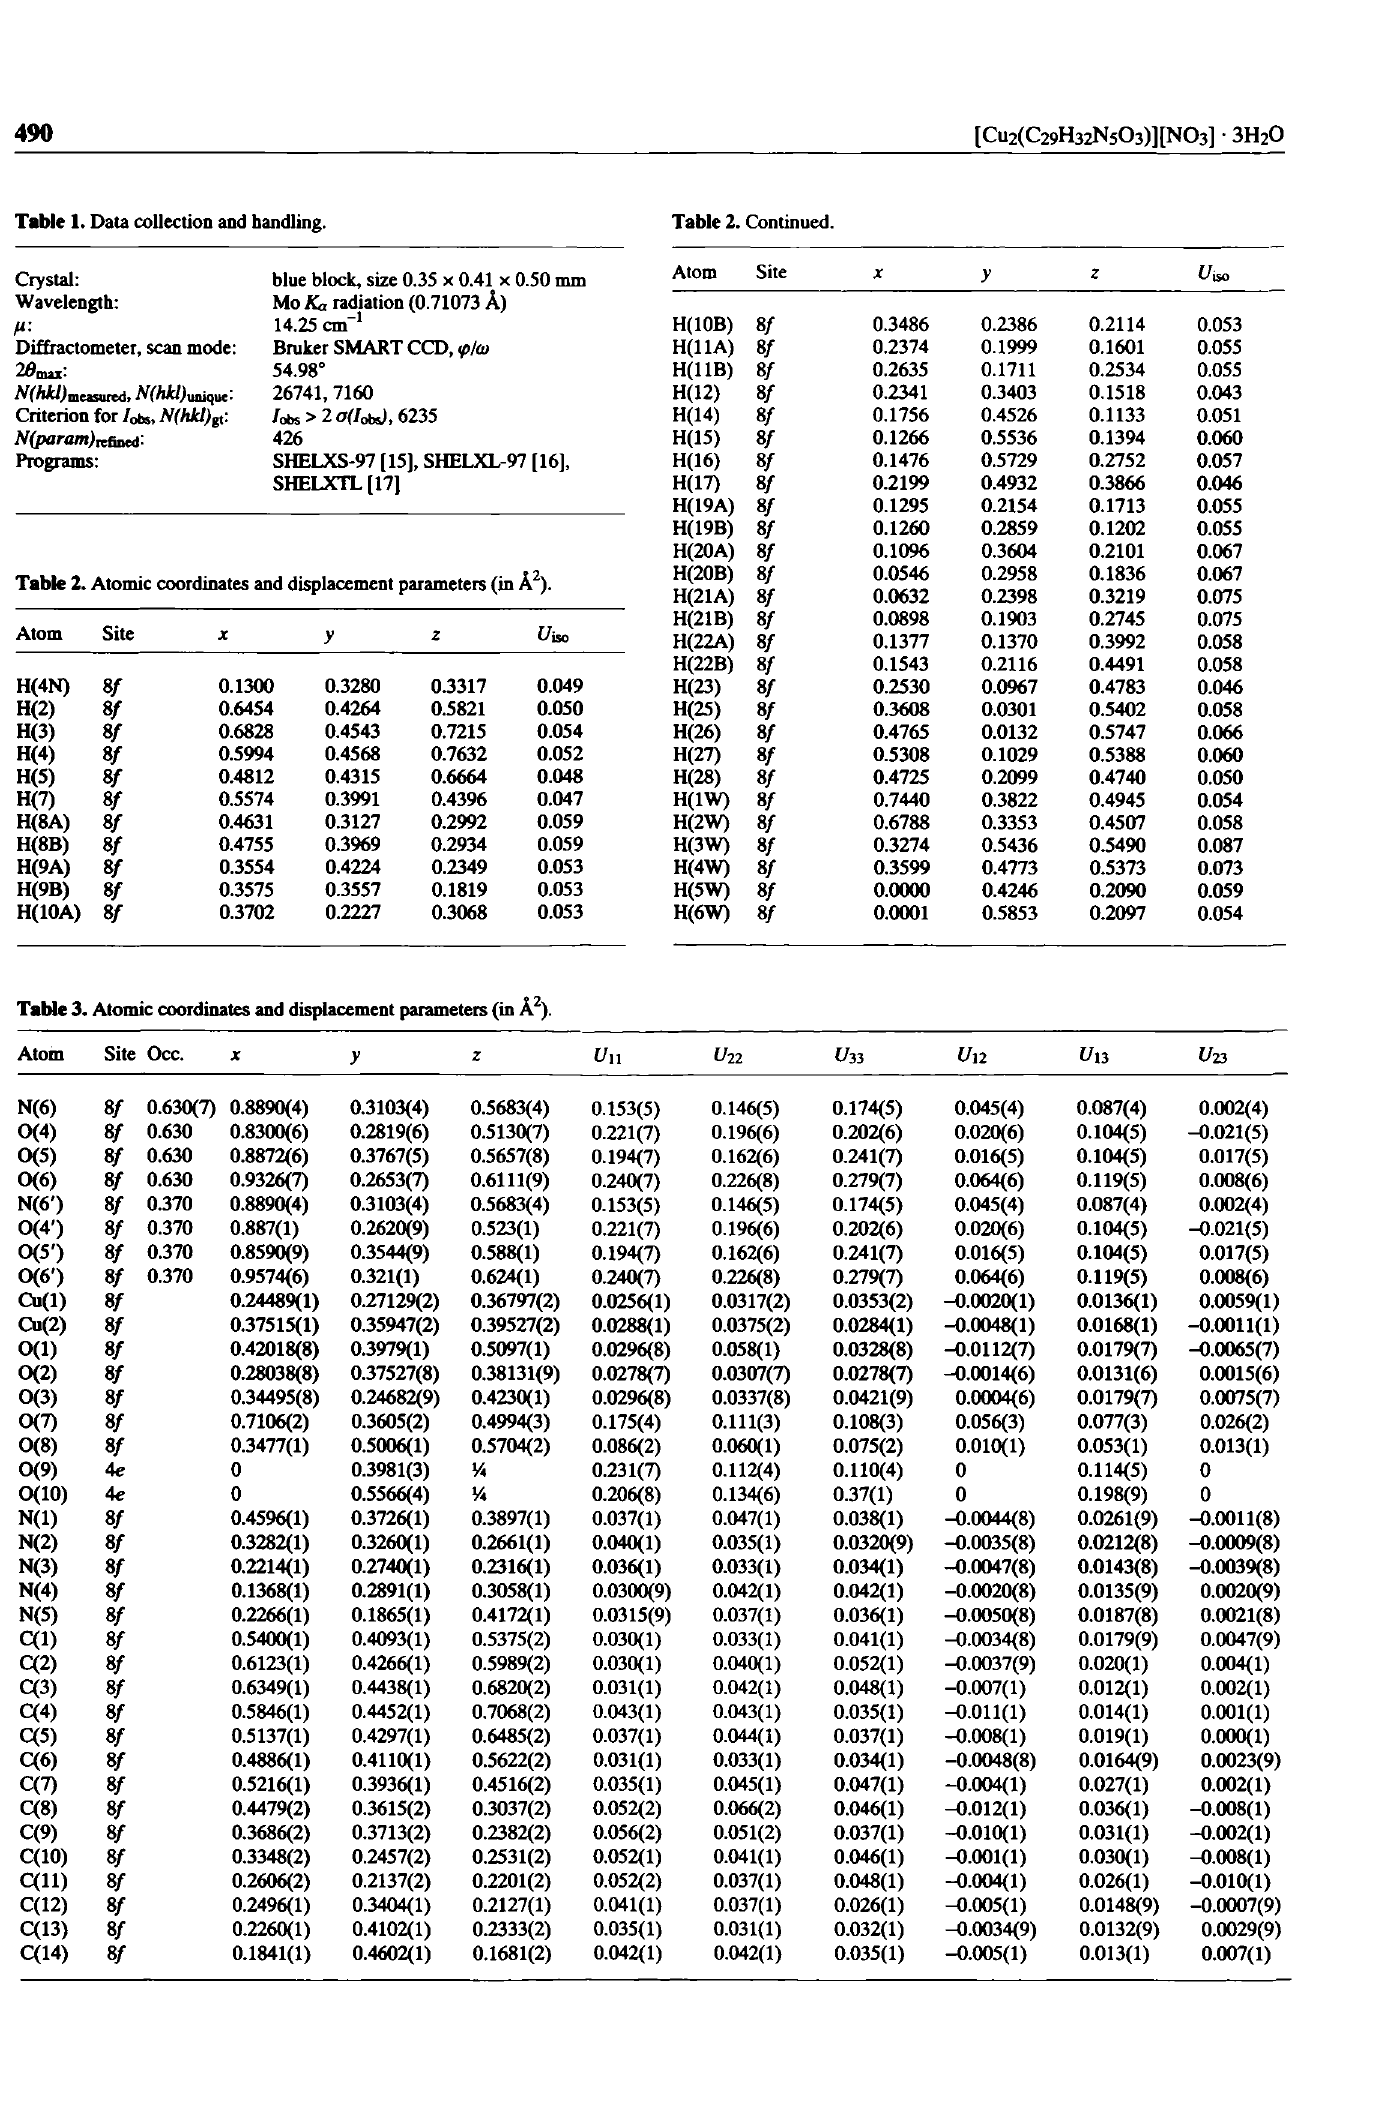
Table 2. Atomic coordinates and displacement parameters (in Ä 2 ).